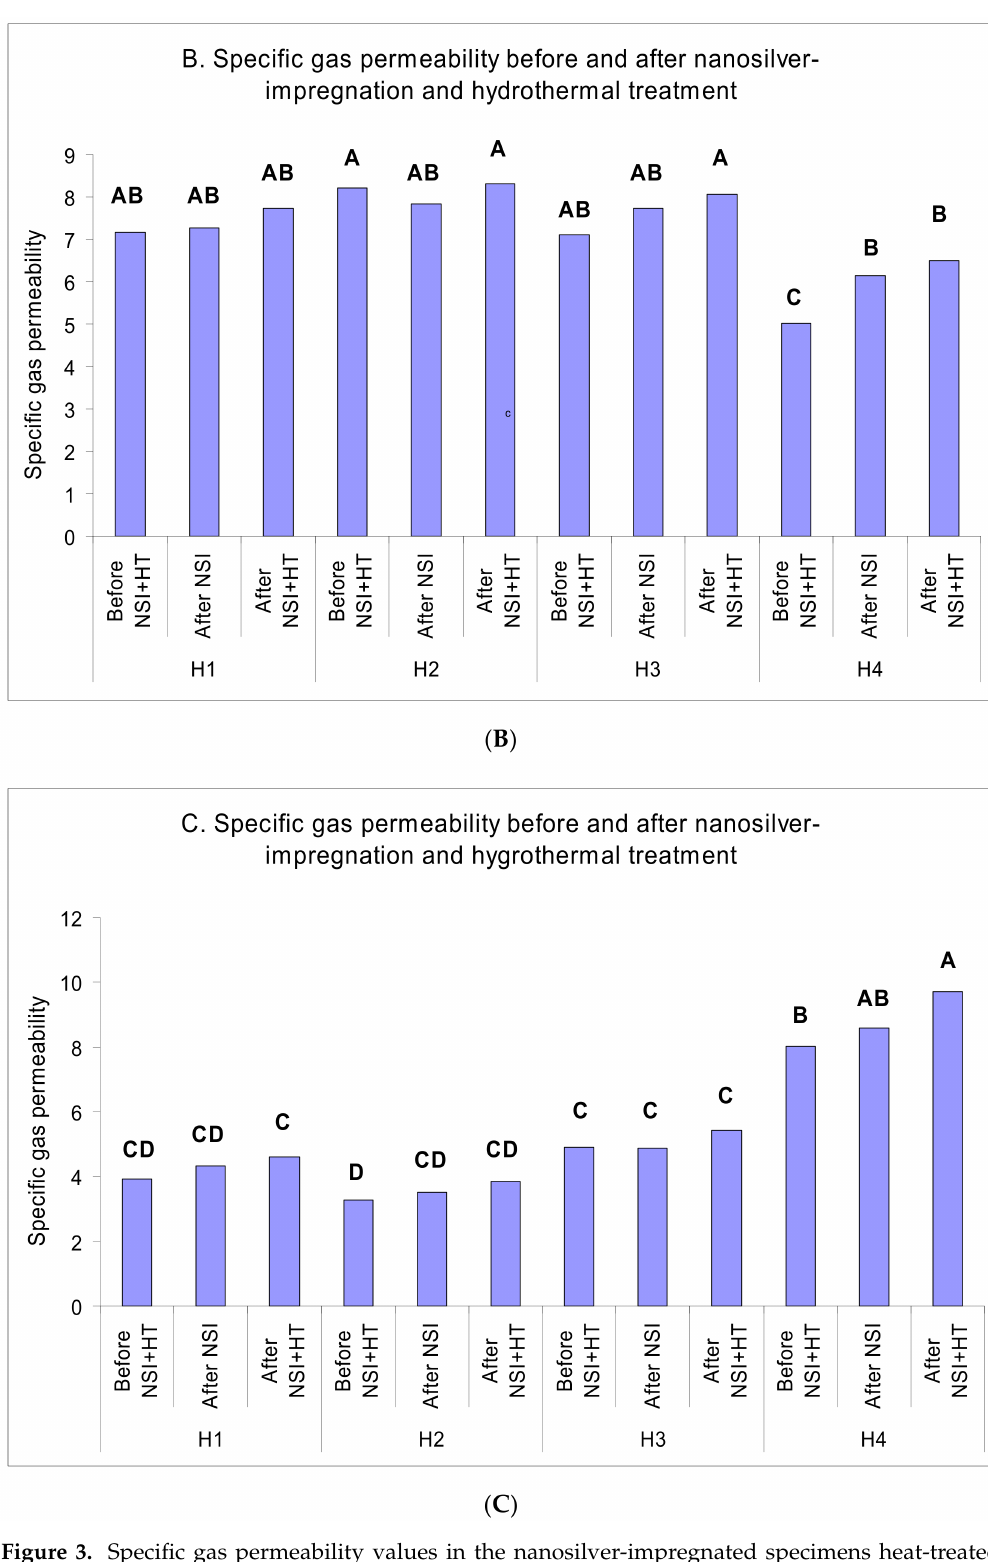
Figure 3. Specific gas permeability values in the nanosilver-impregnated specimens heat-treated in hot-air ( A ), hydrothermal ( B ), and hygrothermal ( C ) mediums ( × 10 − 13 m 3 .m − 1 ) (Gas 5) (HT = heat-treated; NSI = nano-silver impregnated; H numberv = heated at the number of hours) (Letters on each column represents the Duncan